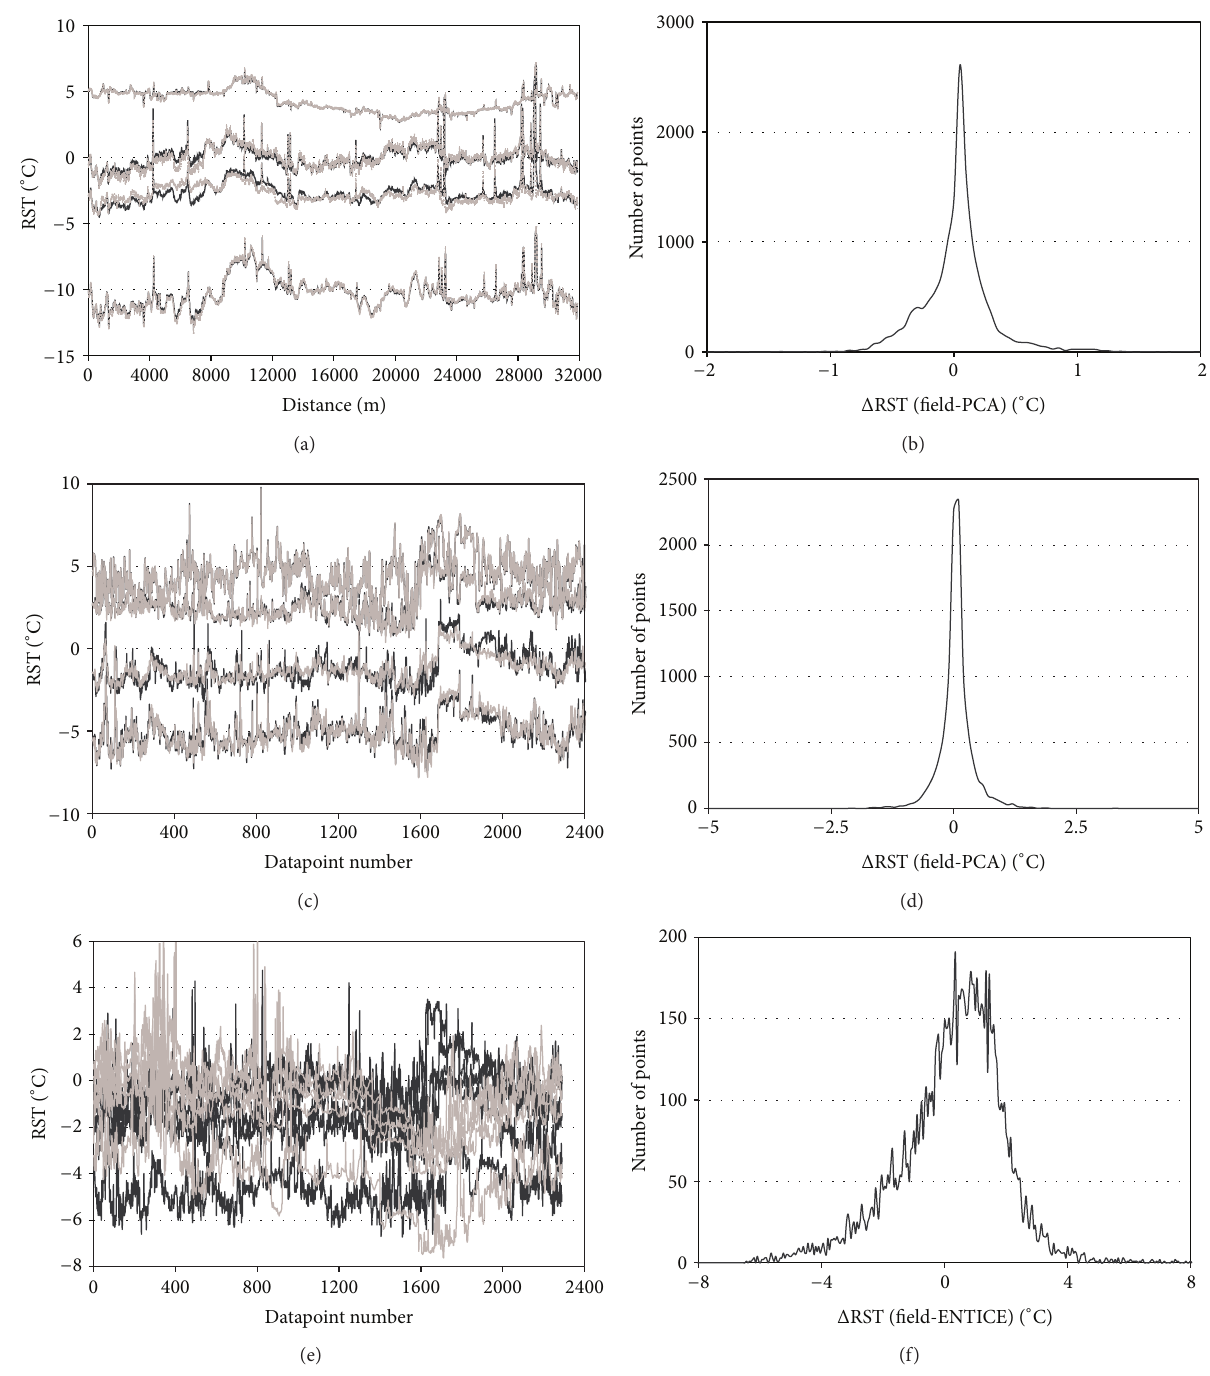
Figure 7: Comparison between RST from field measurements (solid black line) and from PCA and ENTICE calculations (solid gray line) on French (a) and UK ((c) and (e)) routes, and corresponding error distributions ((b), (d), and